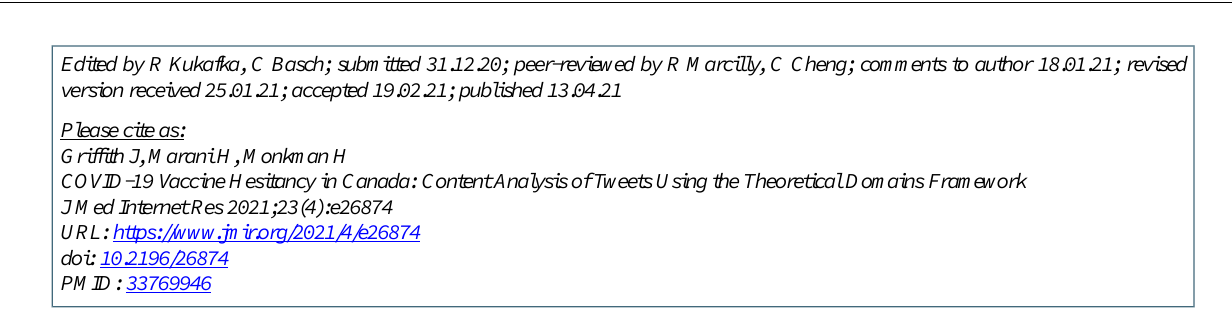
BIPOC: Black, Indigenous, and people of color LGBTQ+: lesbian, gay, bisexual, transgender, queer+ PRISMA: Preferred Reporting Items for Systematic Reviews and Meta-Analyses TDF: Theoretical Domains